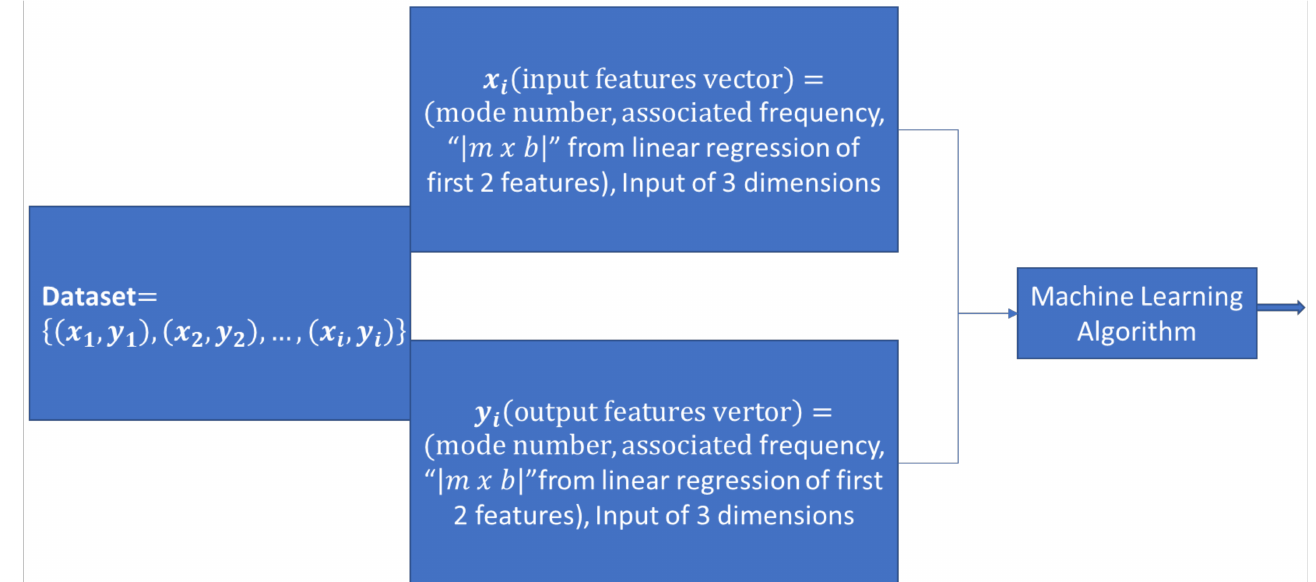
Figure 5. Dataset pre-processing and feeding into machine learning model.